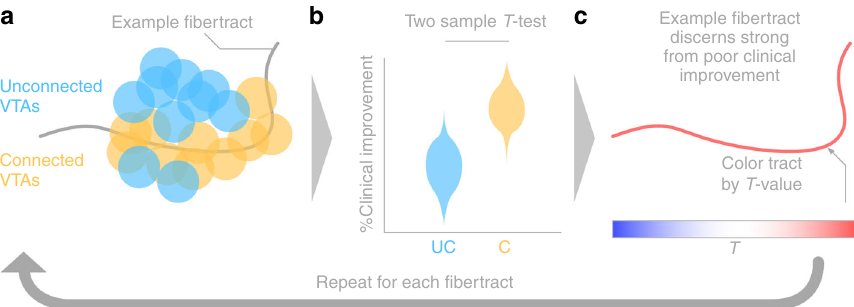
Fig. 7 Summary of methods to de fi ne a T -value for each tract. a For each fi ber, VTAs were grouped into either connected (C; yellow) or unconnected (UC; blue) sets across patients. b Two-sample t -tests between clinical improvements in connected and unconnected VTAs were calculated in a mass- univariate fashion for each fi ber tract separately. c The resulting T -value of this analysis leads to the “ weight ” that each fi ber received, as well as the color in visualizations throughout the manuscript. Here, red means that the fi ber tract is favorably connected to good responders, whereas blue indicates the opposite (and the saturation of tracts denotes how discriminative they